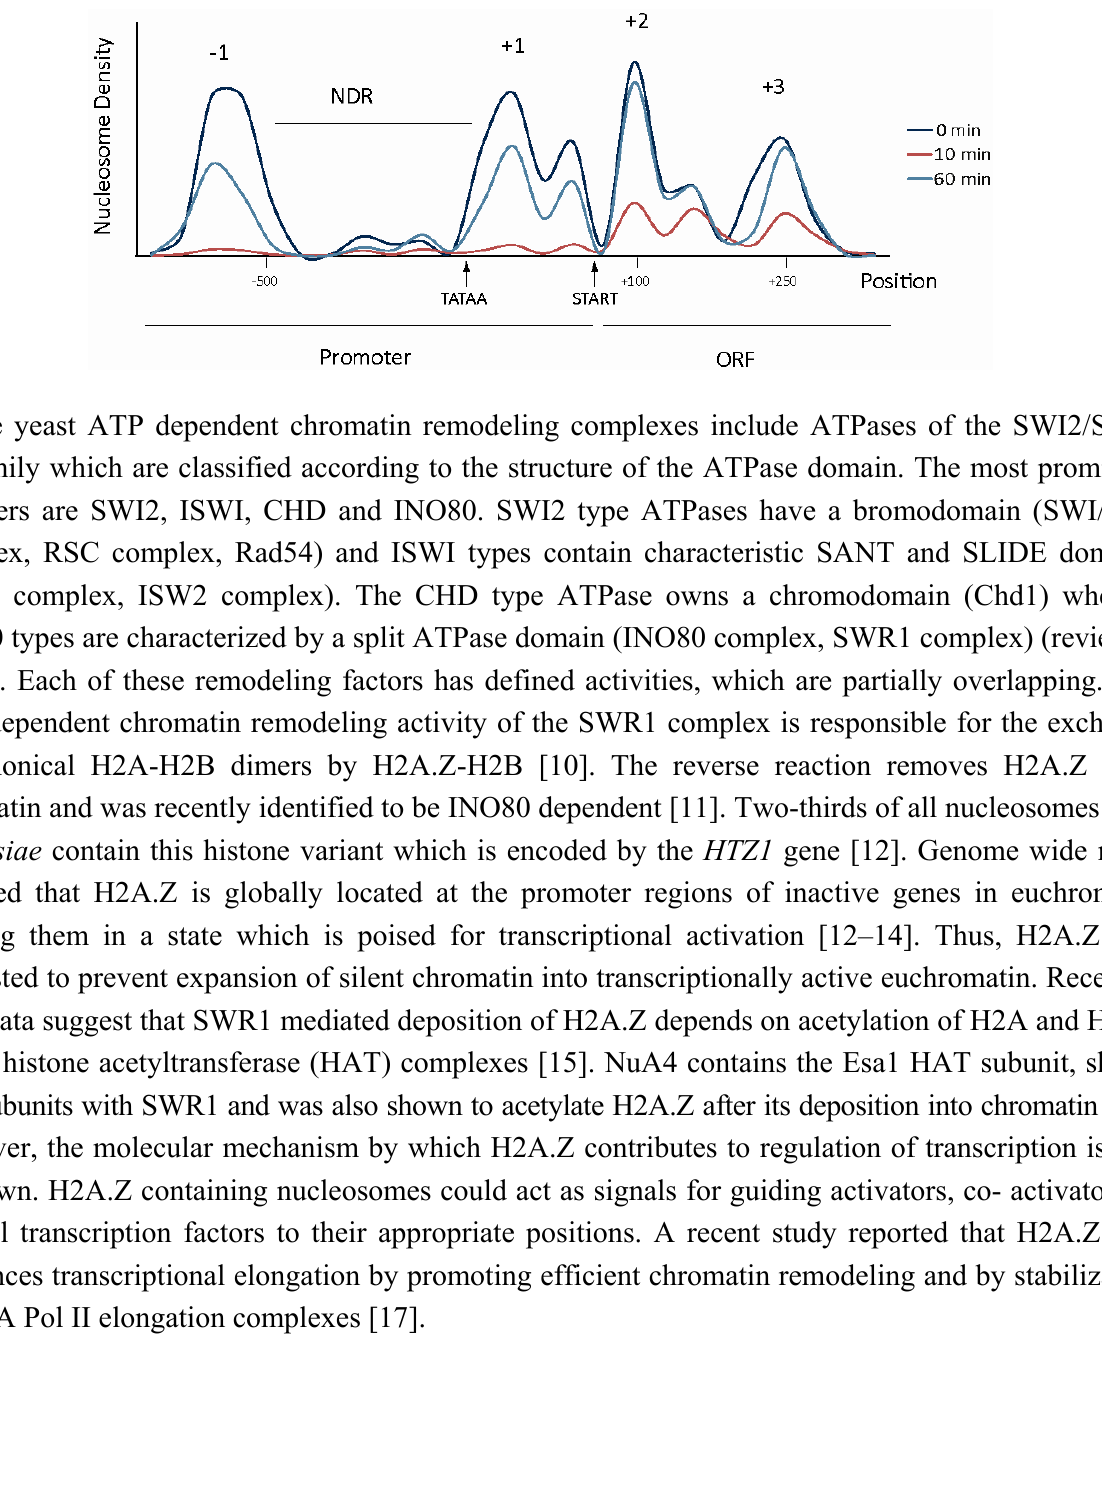
Figure 2. Nucleosome positions at the stress inducible CTT1 locus: The schematic representation shows 4 positioned nucleosomes. During uninduced conditions, two ( − 1 and +1) are flanking the nucleosome depleted region (NDR) and belong to the promoter, whereas nucleosomes +2 and +3 are positioned at the 5’ end of the 1.7 kb long ORF (dark blue line). After induction by hyperosmolarity stress for 10 min (red line) nucleosome levels are severely depleted in the entire region, after 60 min (light blue line) chromatin structure at the ORF reaches uninduced levels whereas promoter nucleosomes are not completely